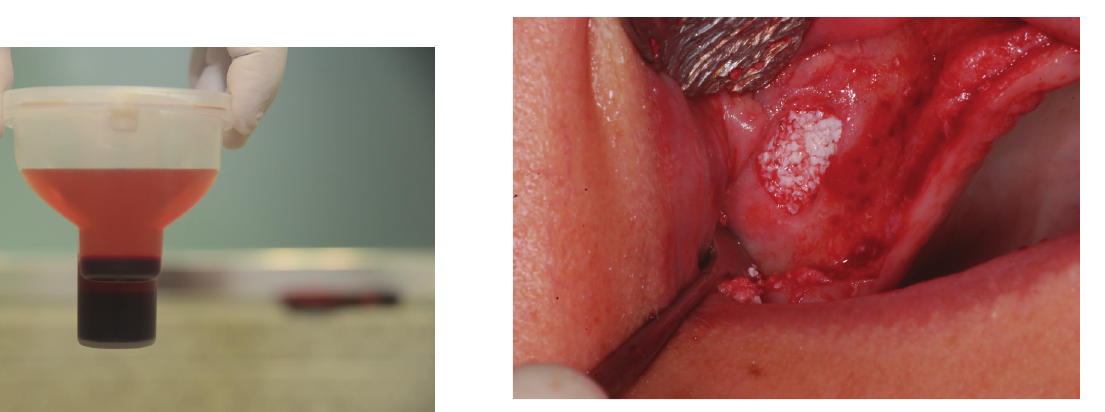
Figure 5: Maxillary sinus was grafted with xenogeneic bone from bovine